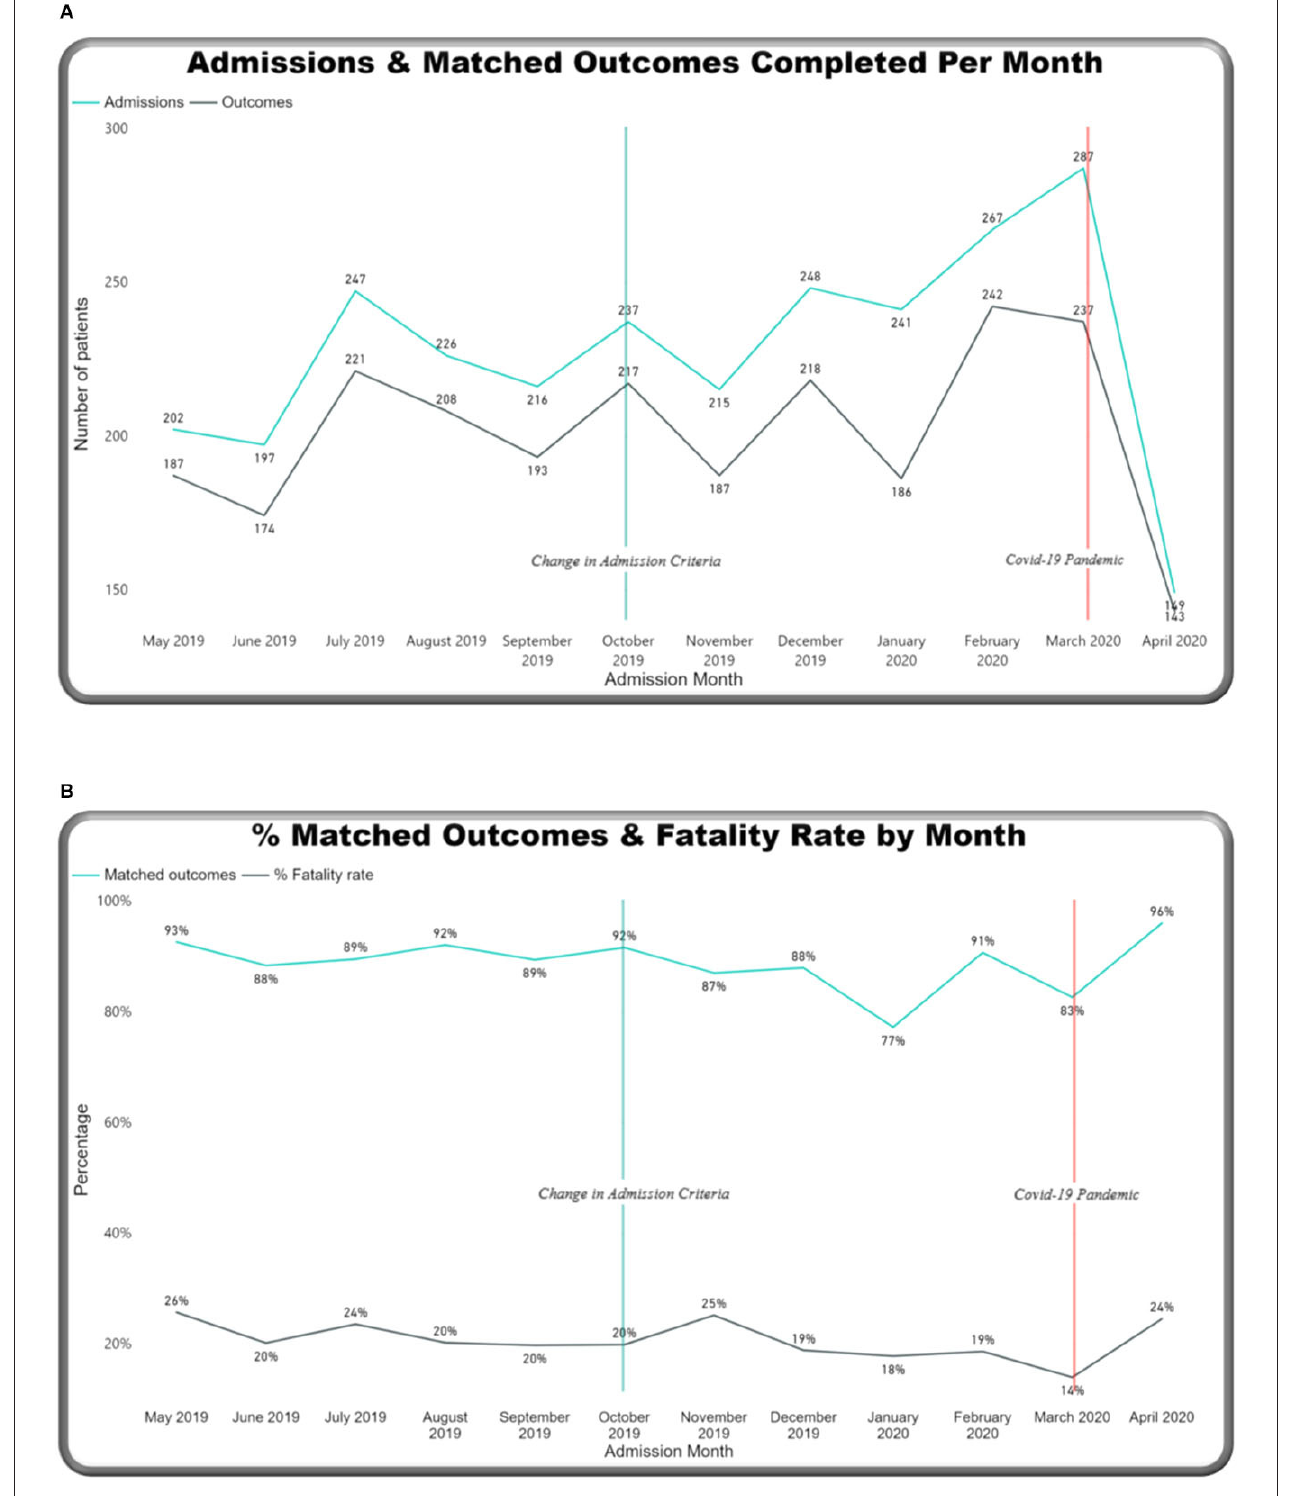
FIGURE 8 | M&M dashboard monthly trends: (A) Admissions & matched outcomes, (B) % matched outcomes and case fatality rates.